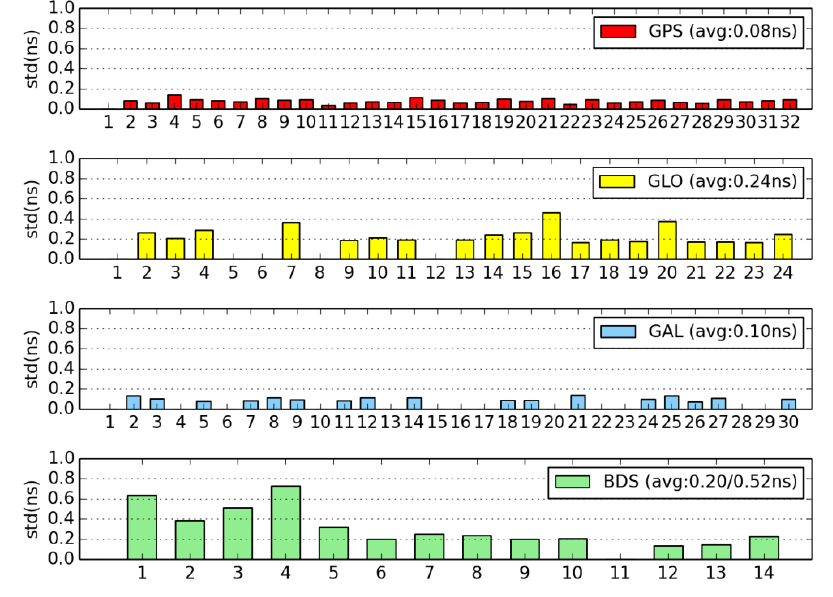
Figure 9. STD of clock difference.